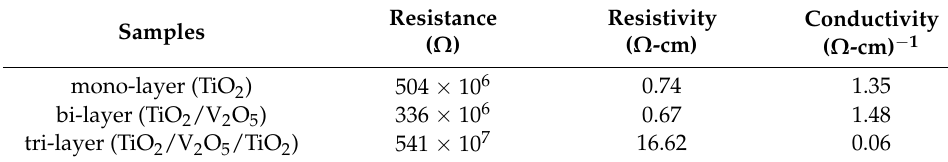
Table 2. Resistance, resistivity, and conductivity of the mono-, bi-, and tri-layers.